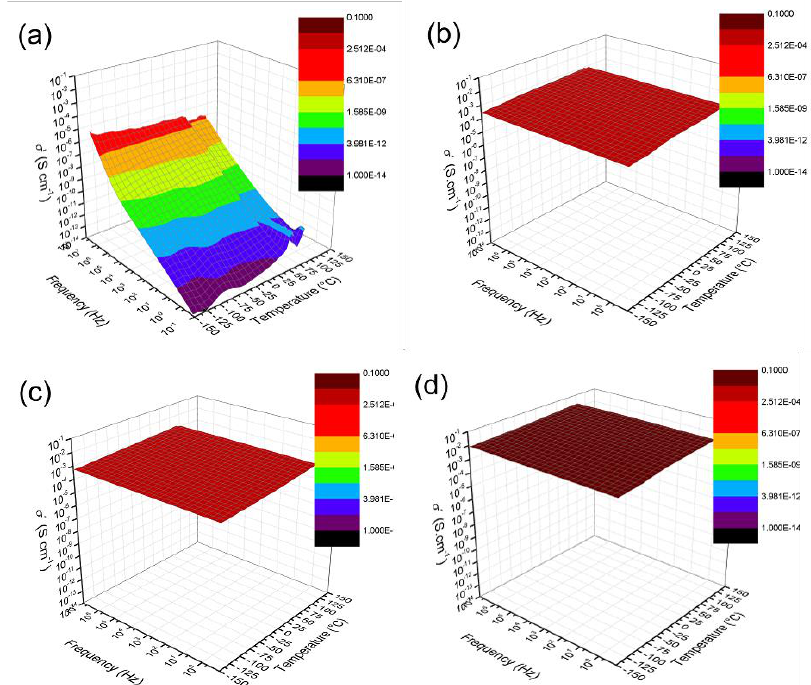
Figure A1. Dielectric maps of coPA / MXene composite films: ( a ) neat coPA, ( b ) 1.0, ( c ) 2.5 and ( d ) 5 wt % of MXene.